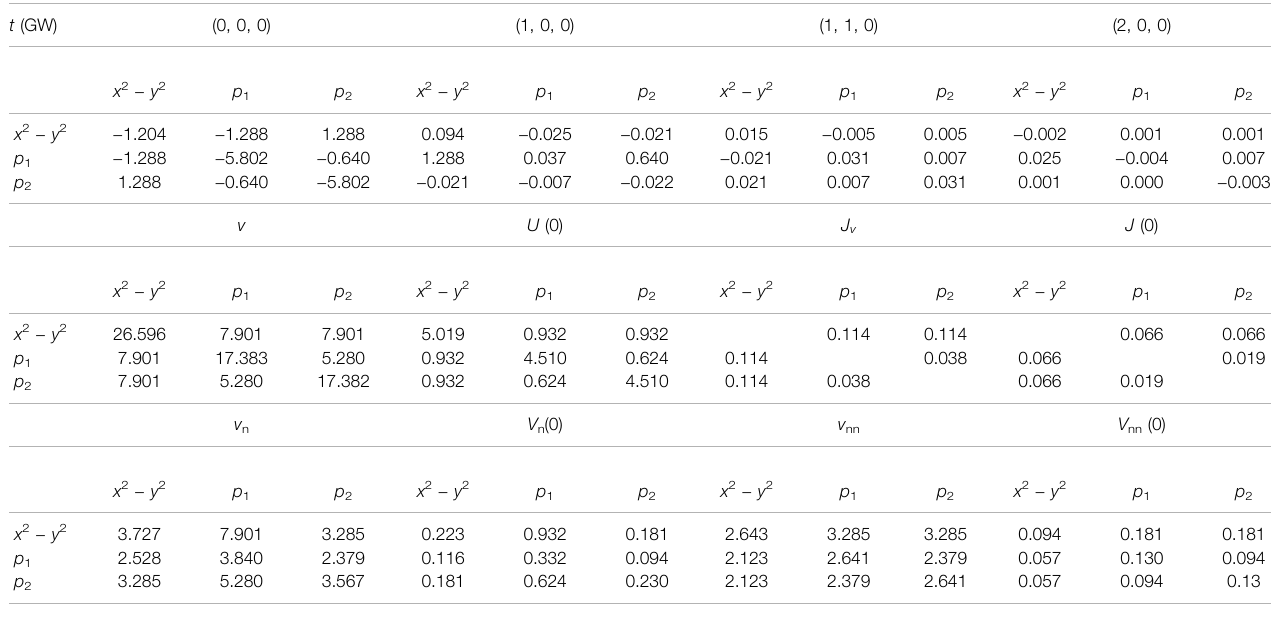
TABLE 2 | Transfer integrals and effective interactions in the three-band Hamiltonian for YNiO 2 (in eV). The one-body part is obtained from the GW band structure, and the effective interaction is the result of the cRPA calculation for the GW bands. v , U (0), J v , and J (0) represent the bare Coulomb, the static values of the effective Coulomb, bare exchange interactions, and exchange interactions, respectively (at ω =0). The index “ n ” and “ nn ” represent the nearest unit cell [1,0,0] and the next-nearest unit cell [1,1,0] respectively.